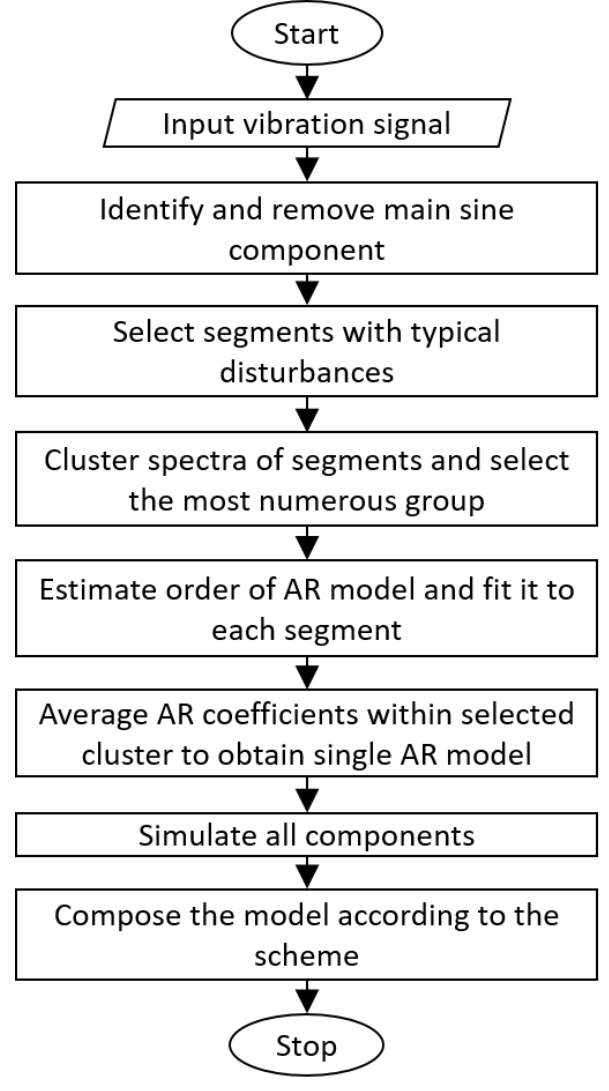
Figure 5. The flowchart of proposed model identification